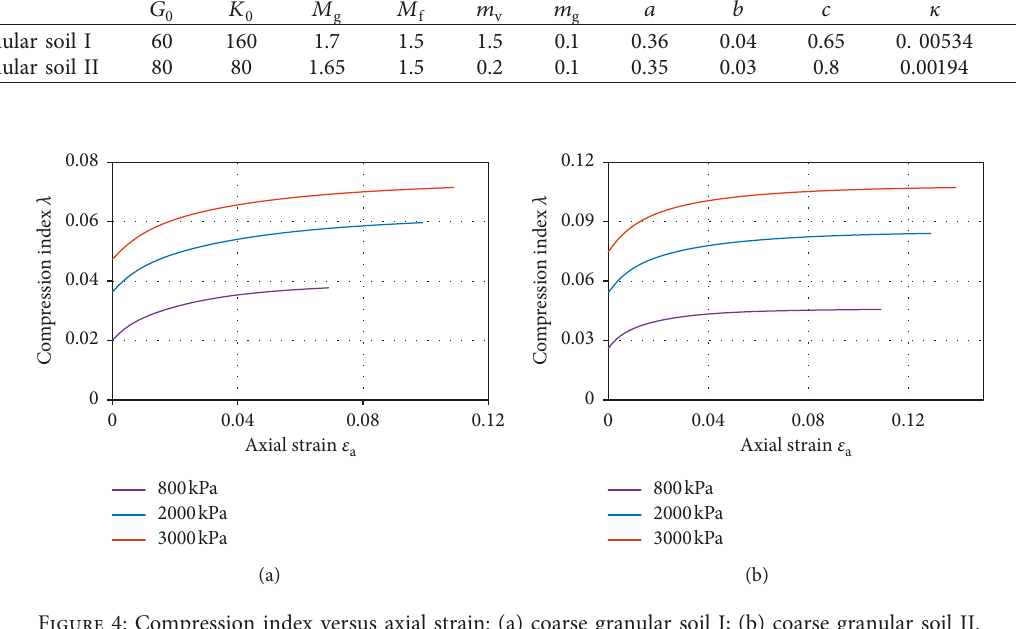
Figure 4: Compression index versus axial strain: (a) coarse granular soil I; (b) coarse granular soil II.